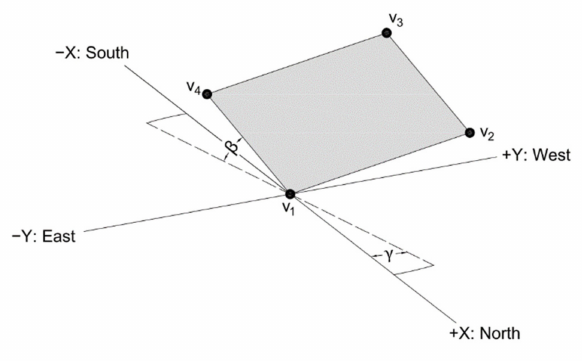
Figure 2. Geometric definition of the vertices v 1 , v 2 , v 3 , and v 4 for a solar module with tilt angle β and azimuth angle γ . Azimuth angles are measured from north and positive